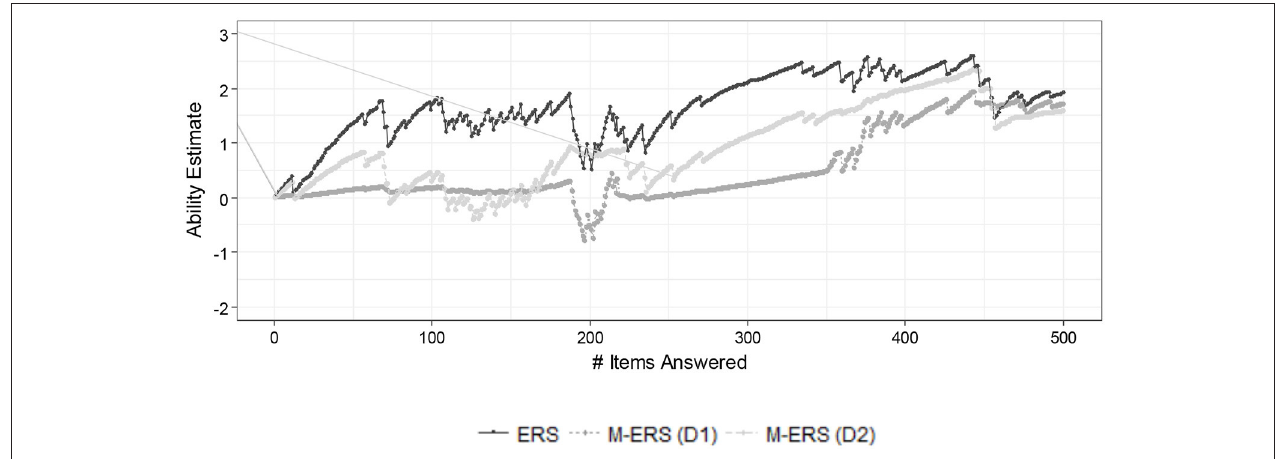
FIGURE 4 | Example of ability estimates for a student by standard ERS and